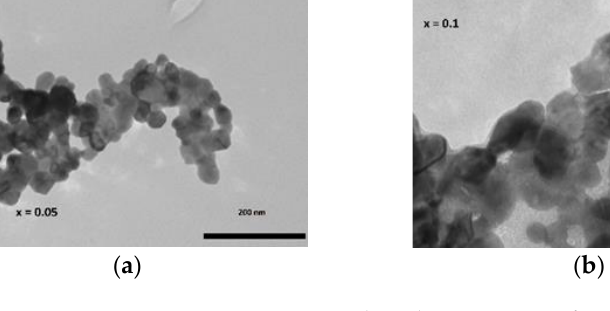
Figure 3. Selected TEM pictures for La 1 − x Eu x MnO 3 nano-sized samples for x = 0.05 ( a ), x = 0.1 ( b ), x = 0.2 ( c ). x = 0.2 ( c